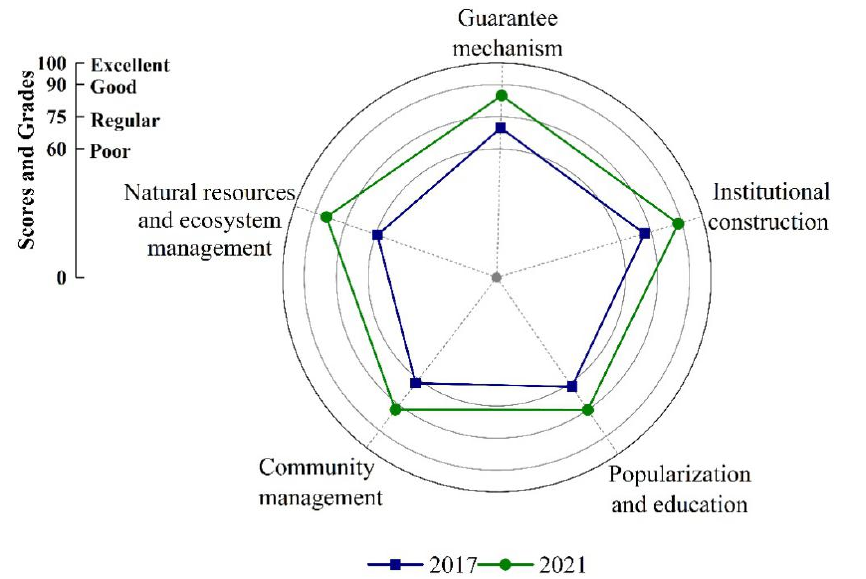
Figure 4. Grades of the comprehensive management capacities of TNP in2017 and 2021.